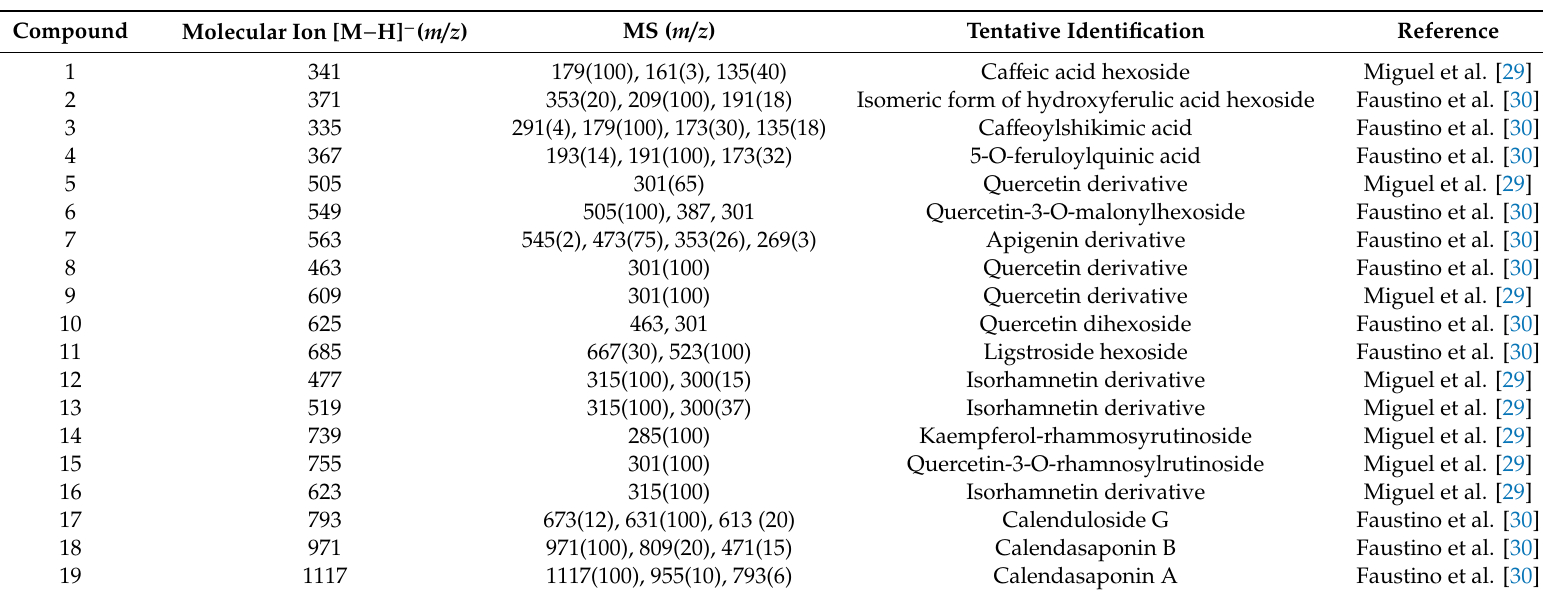
Table 2. Mass spectral data and tentative identification of phenolic compounds in the hydroalcoholic extract of Calendula o ffi cinalis flowers according to the